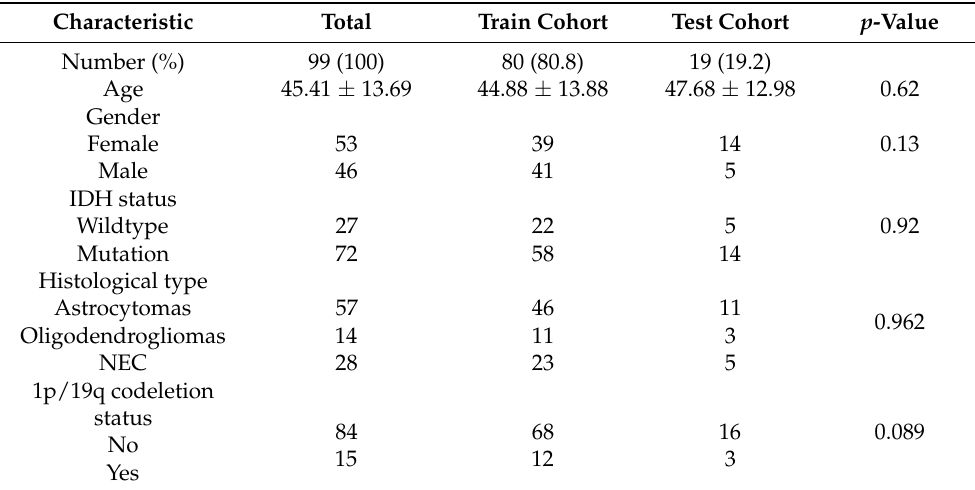
Table 2. Clinical characteristics of the train and test